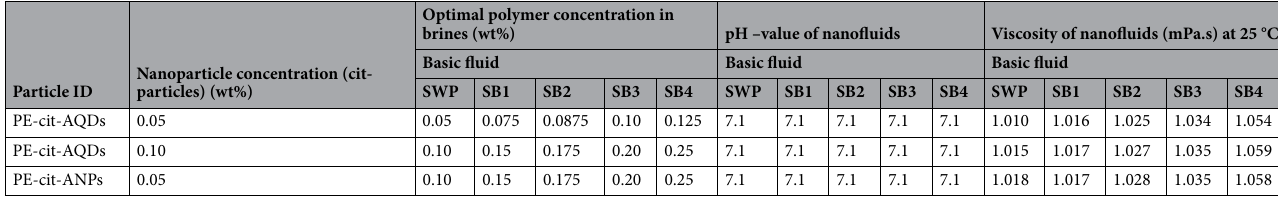
Table 1. The derived experimental parameters for prepared nanofluids from PE-citrate-AQDs/ANPs